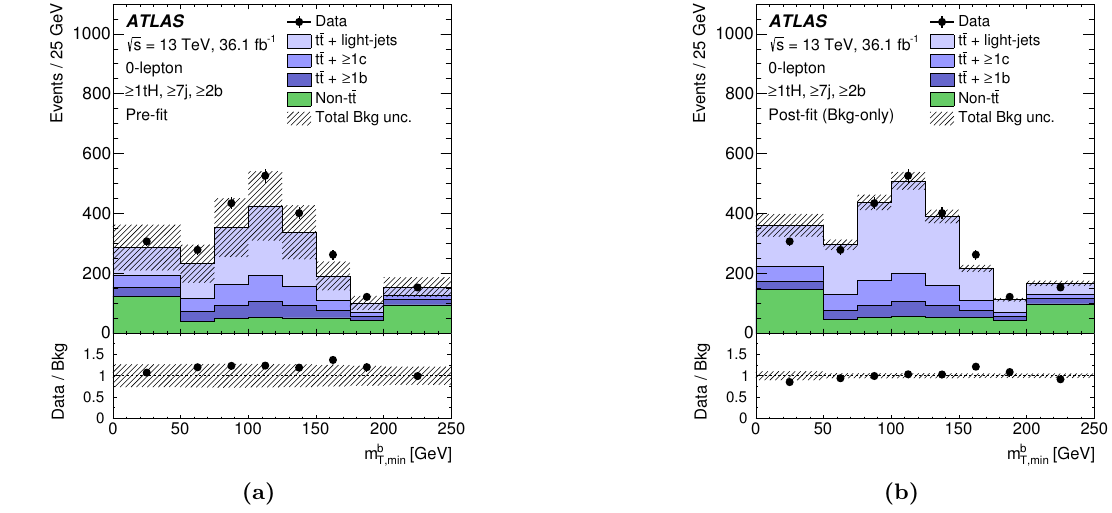
Figure 16. Comparison between the data and prediction for the distribution of the minimum transverse mass of E miss